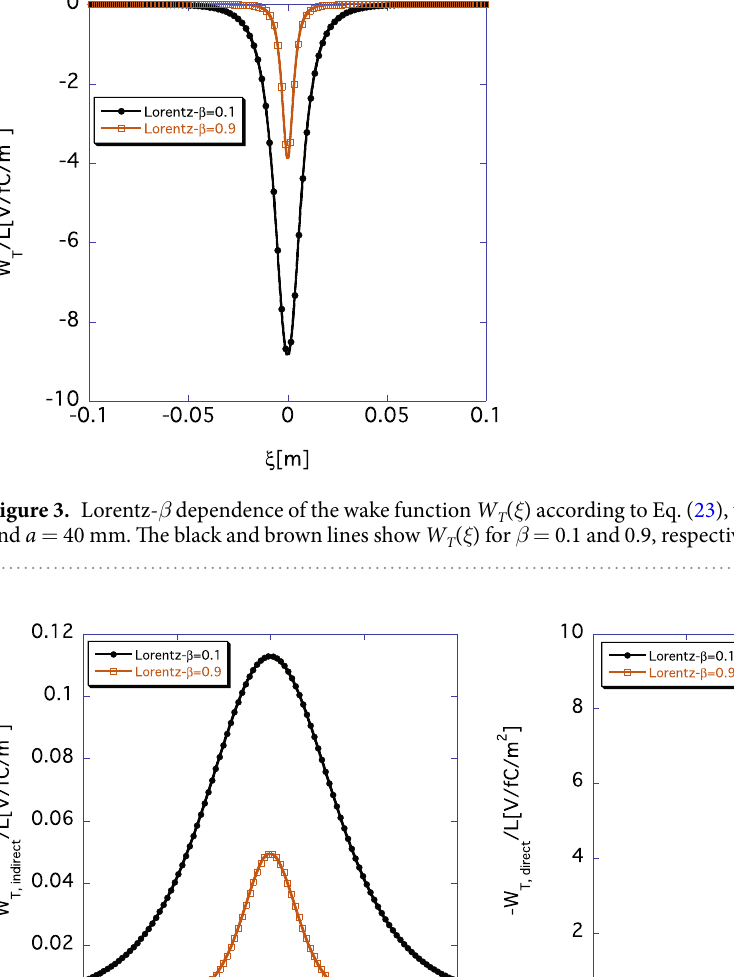
W T , indirect ( ξ ) (left) is broader than the direct one (right) because W T , indirect ( ξ ) is generated by the image charge on the chamber wall, as expected. Because both W T , indirect ( ξ ) and W T , direct ( ξ ) become narrower for a larger Lorentz- γ , the space-charge wake functions W T ( ξ ) approach the δ -functions in an ultra-relativistic beam limit. Figure 5 shows the dependence of the indirect space-charge wake function W T , indirect ( ξ ) on the chamber radius a with fixed beam offset r b by using Eq. (25). The brown, purple, red and green lines (read using the scale mark- ings on the left axis) represent W T , indirect ( ξ ) for a = 40 mm, 60 mm, 80 mm, and 100 mm, respectively. The black line (read using the scale markings on the right axis) shows the W T , direct ( ξ ) determined using Eq. (24) as a ref- erence. The upper and lower panels show the functions W T , indirect ( ξ ) and W T , direct ( ξ ) for β = 0.1, and for β = 0.9, respectively. The panels on the right show the normalized (to the same amplitude) versions of the panels on the left. The shape of the indirect space-charge wake function W T , indirect ( ξ ) becomes broader for β = 0.1 owing to non-relativistic effects. For both β = 0.1 and 0.9, as the chamber radius a increases, W T , indirect ( ξ ) reduces drastically compared to W T , direct ( ξ ). In addition, the shape of the indirect space-charge wake functions W T , indirect ( ξ ) becomes broader as the chamber radius increases. Again, this tendency reflects the fact that the indirect space-charge wake function W T , indirect ( ξ ) is created by the image charge that spreads out by 2 a / γ on the chamber wall. Finally, the dependences of the indirect wake function W T , indirect ( ξ ) and the direct one W T , direct ( ξ ) on the rms bunch length σ z are shown in Fig. 6, which are obtained by using Eqs (24) and (25), respectively, for the case of r b = 10 mm and a = 40 mm, although the wake function W T ( ξ ), or impedance Z T ( ω ), is conventionally defined for infinitesimal σ z = 0. The left and right panels in Fig. 6 show the functions W T , indirect ( ξ ) and W T , direct ( ξ ) for σ z = 0 m, and for σ z = 1 m, respectively. The dashed (read using the scale marking on the left axis) and the solid (read